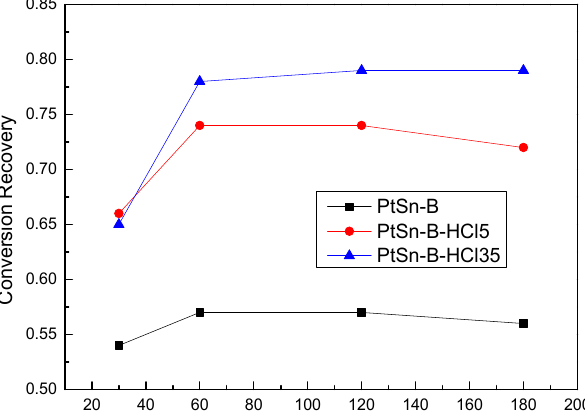
Figure 1. Recovery of propane conversion over Pt-Sn/Al 2 O 3 . Reaction conditions—catalyst weight: 0.3 g; reaction temperature: 600 °C; and flow rate: N 2 :H 2 :C 3 H 8 = 70:30:30 (mL/min), WHSV = 11.8 h − 1 .